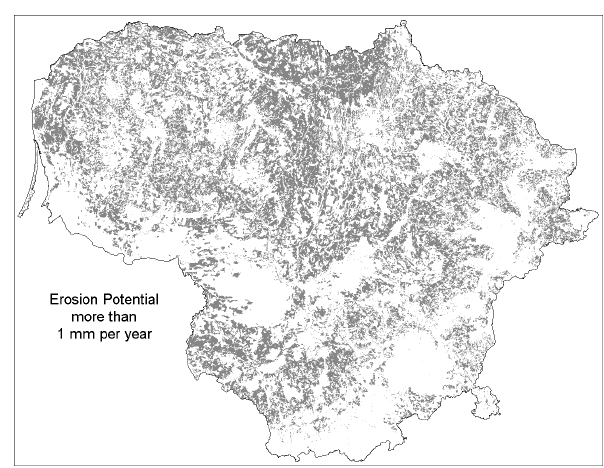
Fig 4 . Sub-soil lithology factor